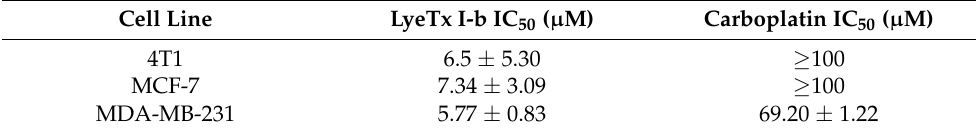
Table 1. IC 50 values of LyeTxI-b and carboplatin against cancer cell lines. Cell Line